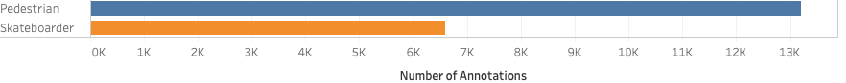
Figure 5. Total number of annotations of skateboarders and pedestrians. All ground truth areas in images were hand-annotated using the VGG Annotator in the San Diego State University Internet of Things Laboratory [26].